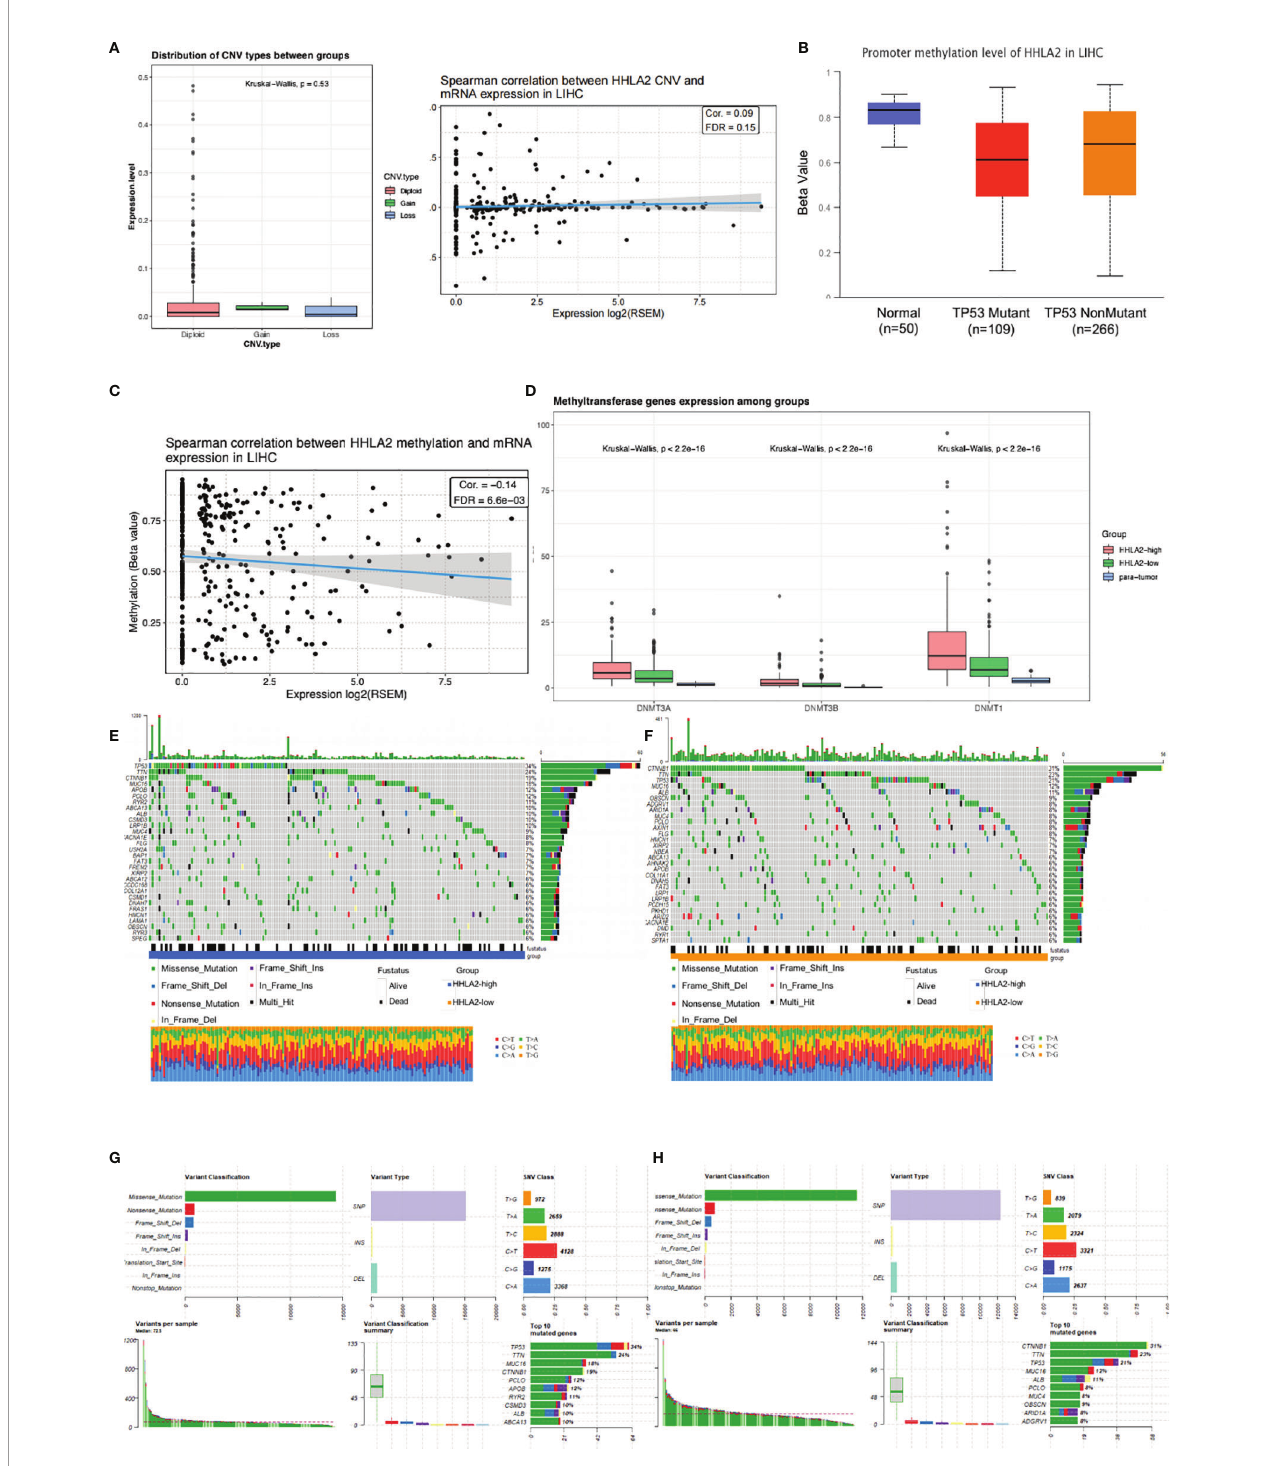
FIGURE 3 | Molecular landscape of different HHLA2 subgroups. (A) Relationship between HHLA2 expression level and its copy number variations. (B) Comparisons of promoter methylation level of HHLA2 among TP53-mutant HCC, TP53-nonmutant HCC, and normal tissues. (C) Spearman correlation between HHLA2 methylation and its expression in LIHC. (D) Comparisons of three methyltransferase genes among HHLA2-high, HHLA2-low, and normal tissues. (E) Somatic landscape of HCC in HHLA2-high subgroup. (F) Somatic landscape of HCC in HHLA2-low subgroup. (G) Overall somatic alterations in HHLA2-high subgroup. (H) Overall somatic alterations in HHLA2-low